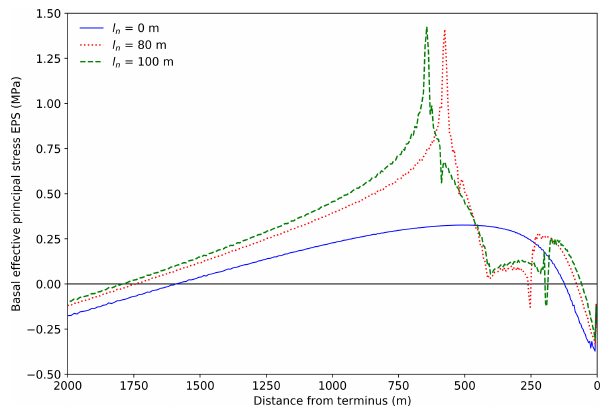
Figure 5. Plots of basal effective principal stress for l n = 0m, 80 and 100m. d w = 900m, h t = 980m, α = 3 ◦ and C = 5 . 623 × 10 6 Pam − 1 / 3 s 1 / 3 . The large basal stress concentrations from Fig. 4 correspond to the peak and trough in the l n = 100m plot. Un- grounding occurred between approximately 250 and 575m for l n = 80m and between approximately 190 and 640m for l n = 100m. Note that for this setup, the critical notch length l crit = 79m.